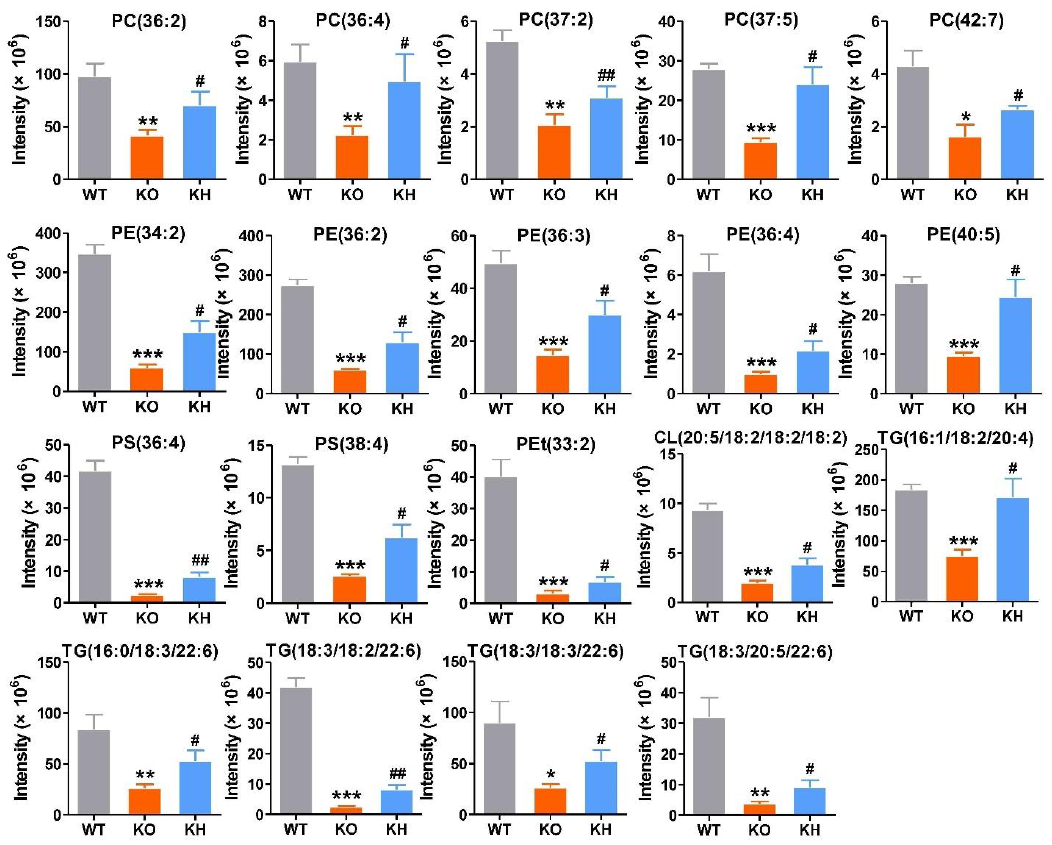
Figure 6. Nineteen lipid species were significant reversibly increased by HTE in liver of Lepr − / − rats. Values are the mean ± SEM ( n = 4). * p < 0.05, ** p < 0.01, *** p < 0.001, compared to WT group; # p < 0.05, ## p < 0.01 versus KO